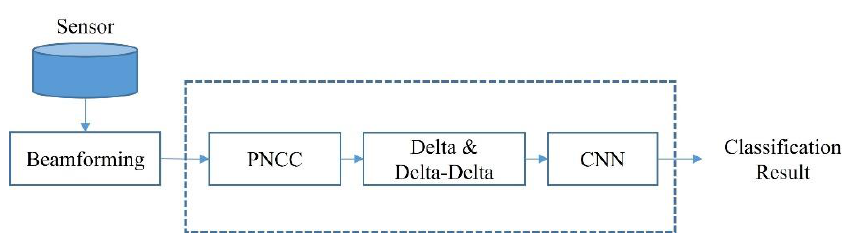
Figure 4. The proposed classification diagram.